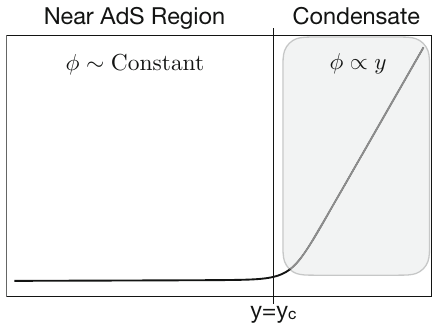
Fig. 1 This cartoon shows the evolution of the field φ . It begins in a region where φ is nearly constant, and the geometry is nearly AdS. At a critical value of the coordinate, y = y c which is close in proper distance to a curvature singularity, φ then begins linear evolution, as shown and the curvature quickly grows large. The gap of the theory is set by the position of this “soft